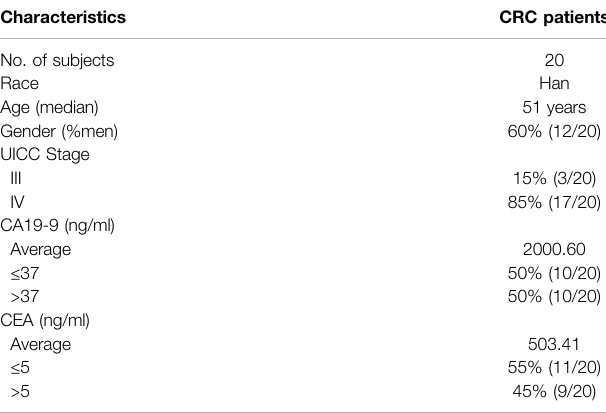
TABLE 1 | Characteristics of 20 CRC